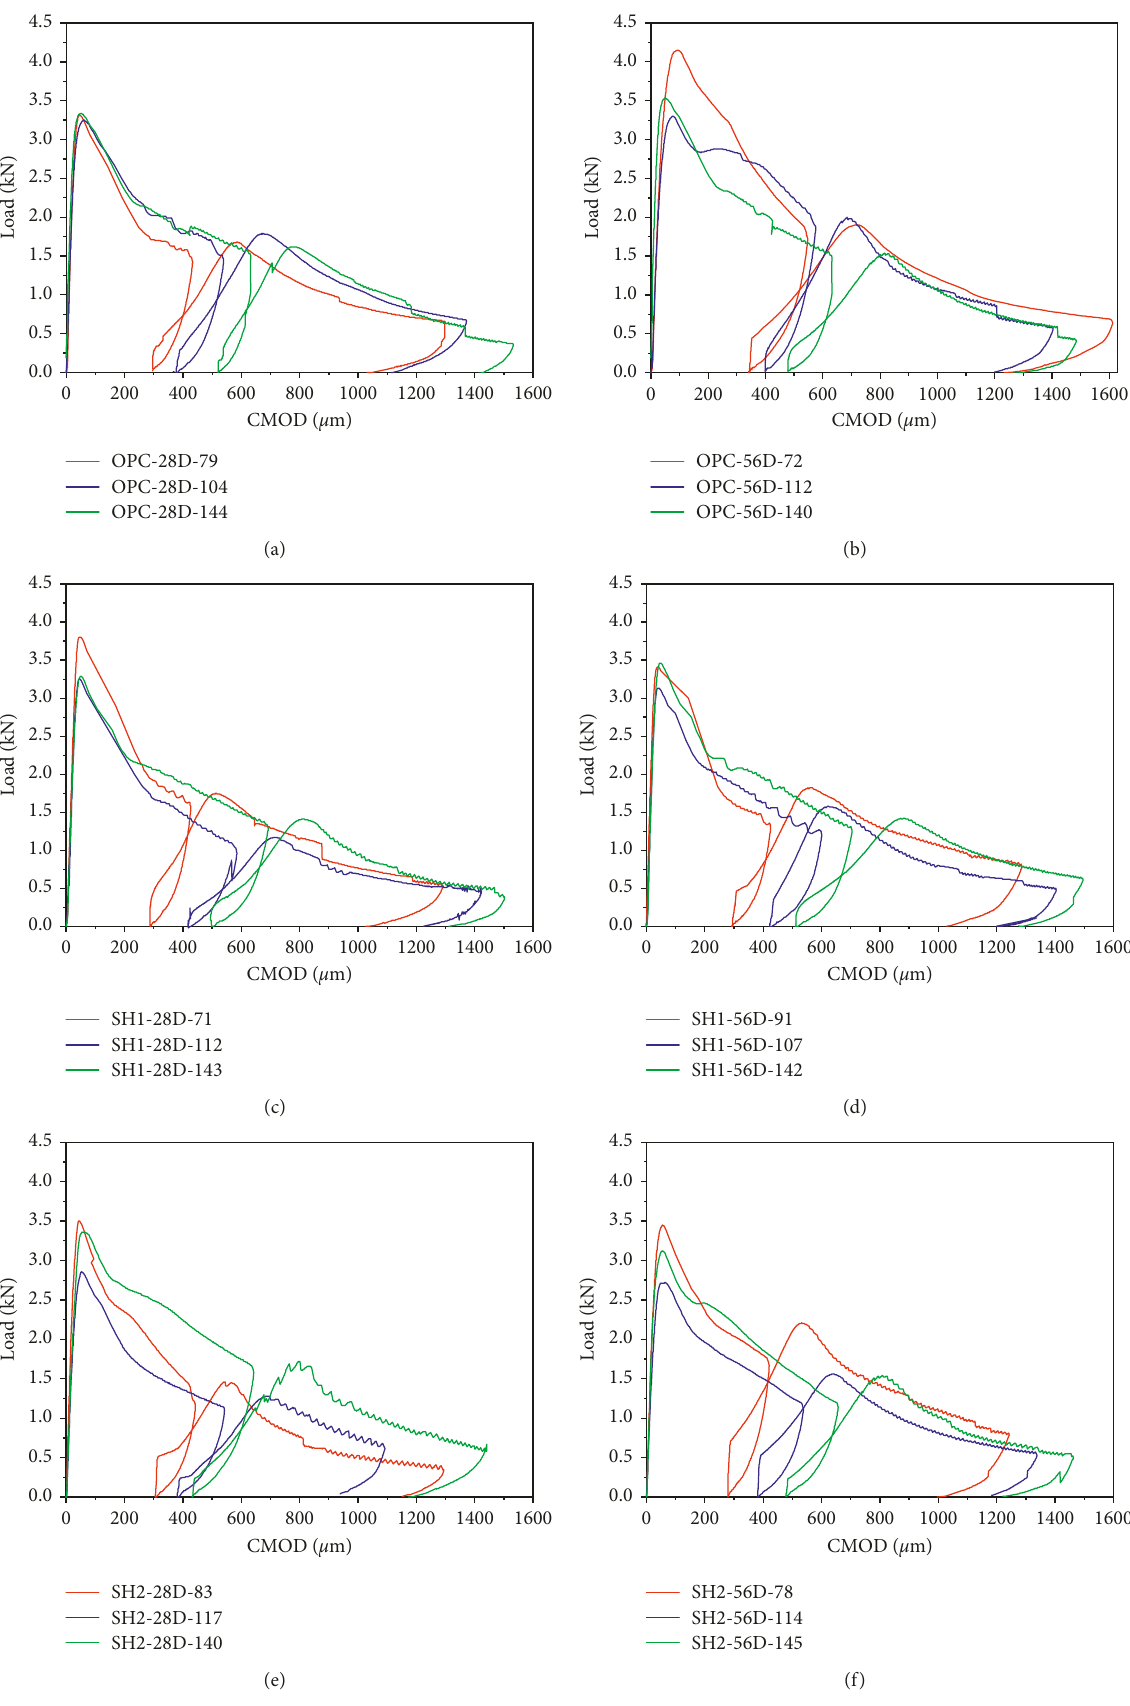
Figure 6: Load versus CMOD for specimens of all mix types, healed for durations of 28 or 56 days: (a) OPC, 28 days; (b) OPC, 56 days; (c) SH1, 28 days; (d) SH1, 56 days; (e) SH2, 28 days; (f) SH2, 56